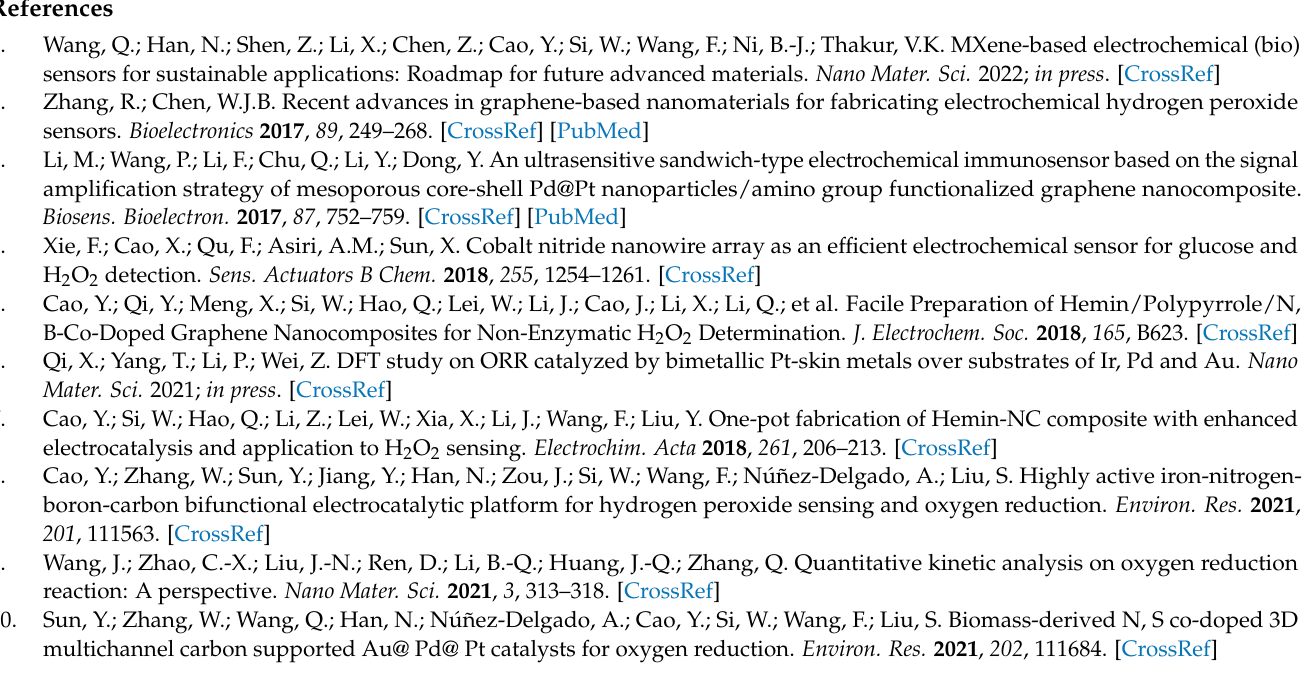
Figure S4: CVs of the Fe-BC-900/GCE in 0.1 M KOH with 0.1 mM H 2 O 2 solution at the first cycle and the 100 cycles,